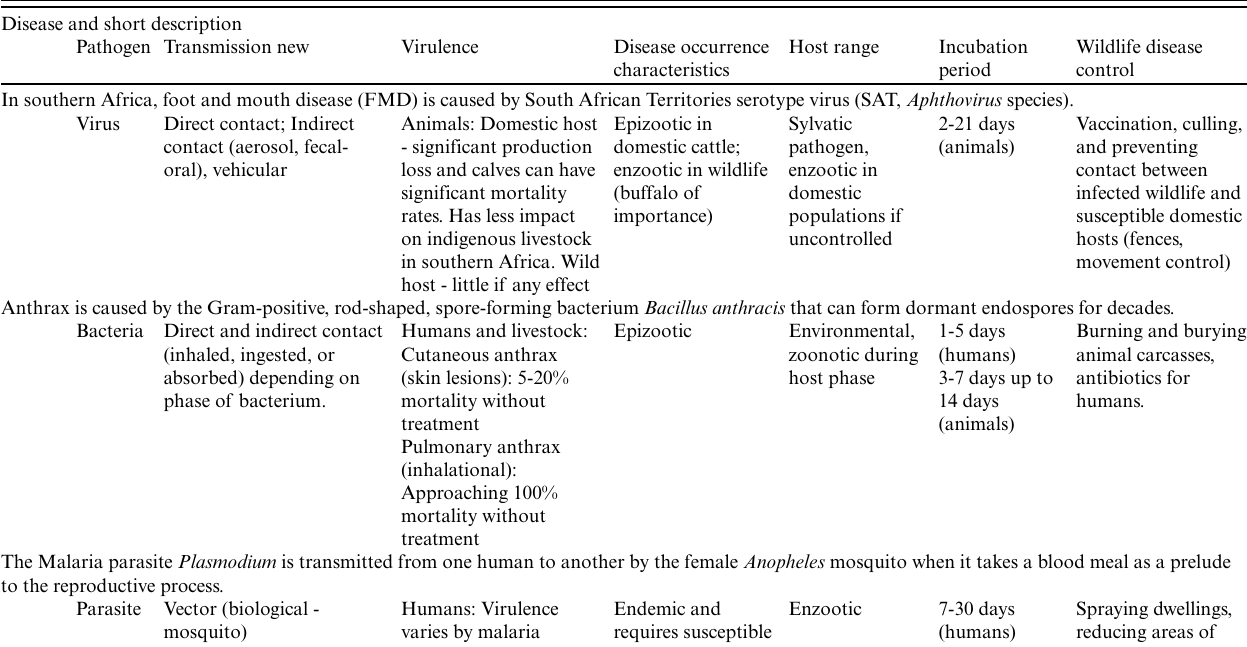
Table 3 . Case study diseases considered in this analysis, chosen for their significant impact on the resilience of southern African protected areas in the past 100 years, and to be typologically representative (as outlined in Table